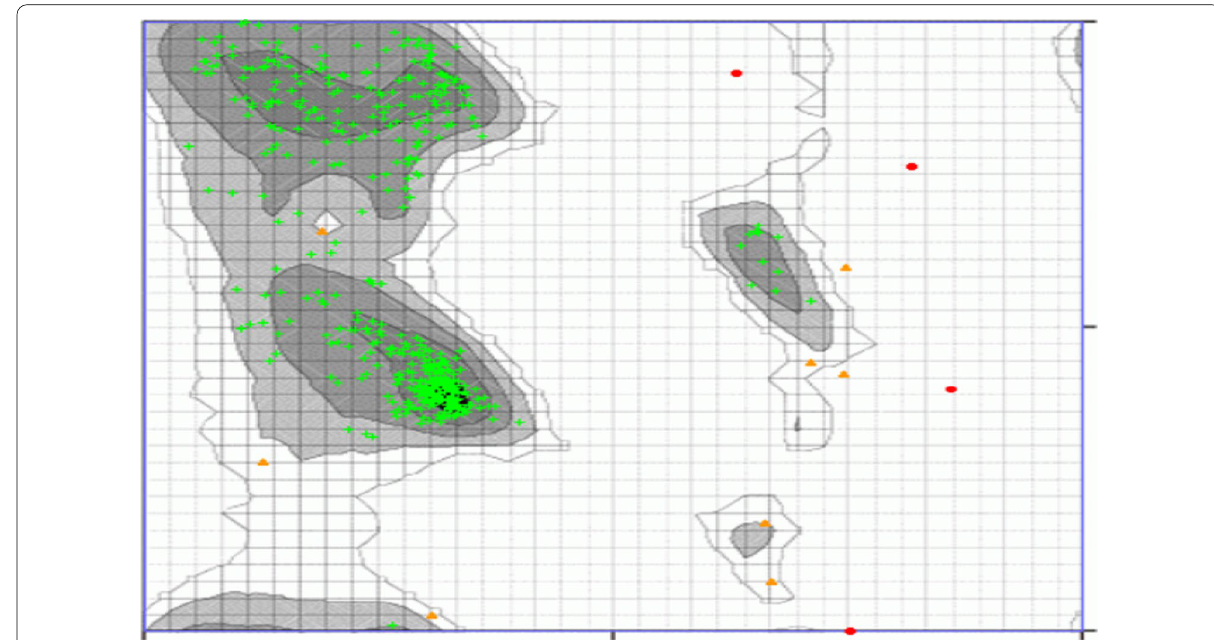
Fig. 4 G. mellonella AChE protein structure by Ramachandran plot with 97% of amino acids (https:// zlab. umass med. edu/)